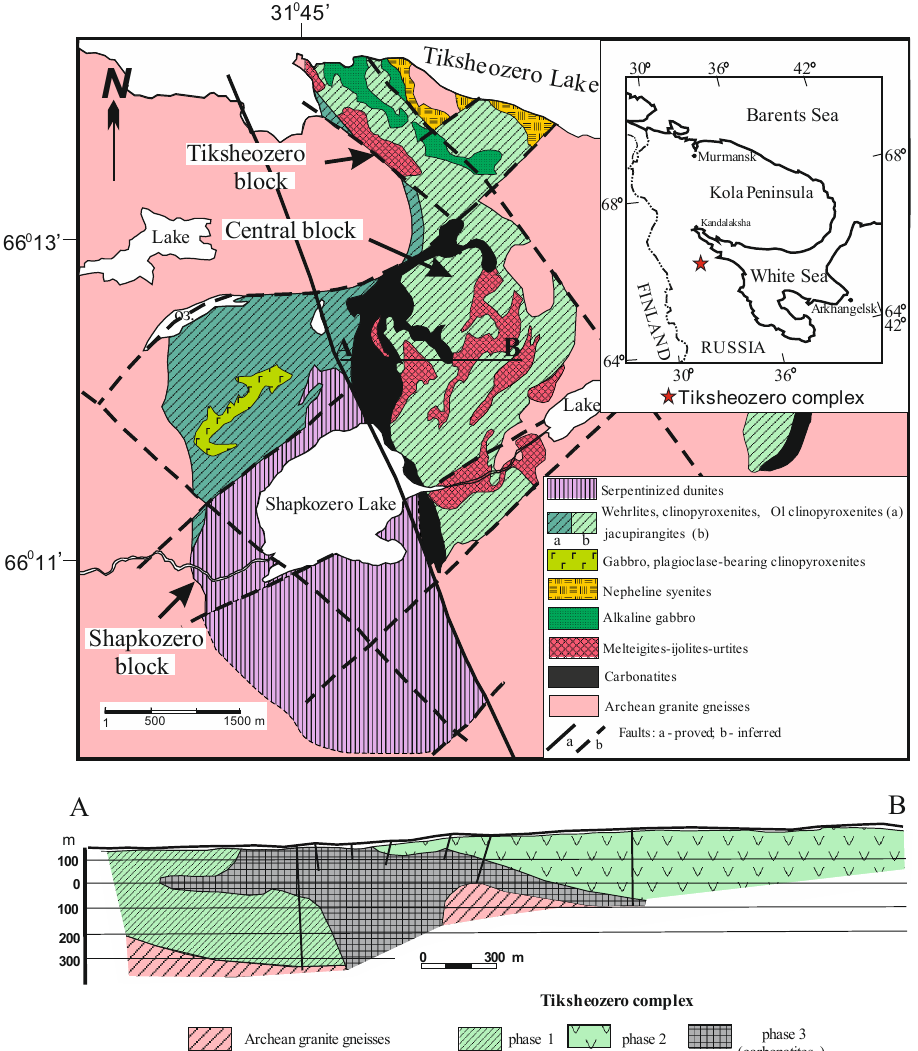
Figure 1. Geological scheme of the Tiksheozero Complex (modified after [30]), its geographical position (inset), and geological cross-section along line A-B.